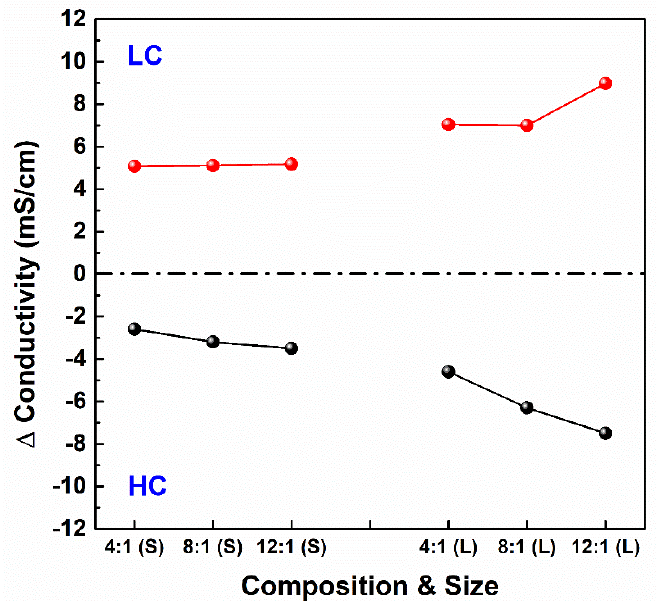
Figure 7. Conductivity difference between the inlet and the outlet of both low ‐ concentrated (LC) feed water and high ‐ concentrated (HC) feed water according to the PIEM composition and RED feed water and high-concentrated (HC) feed water according to the PIEM composition and RED stack size. stack